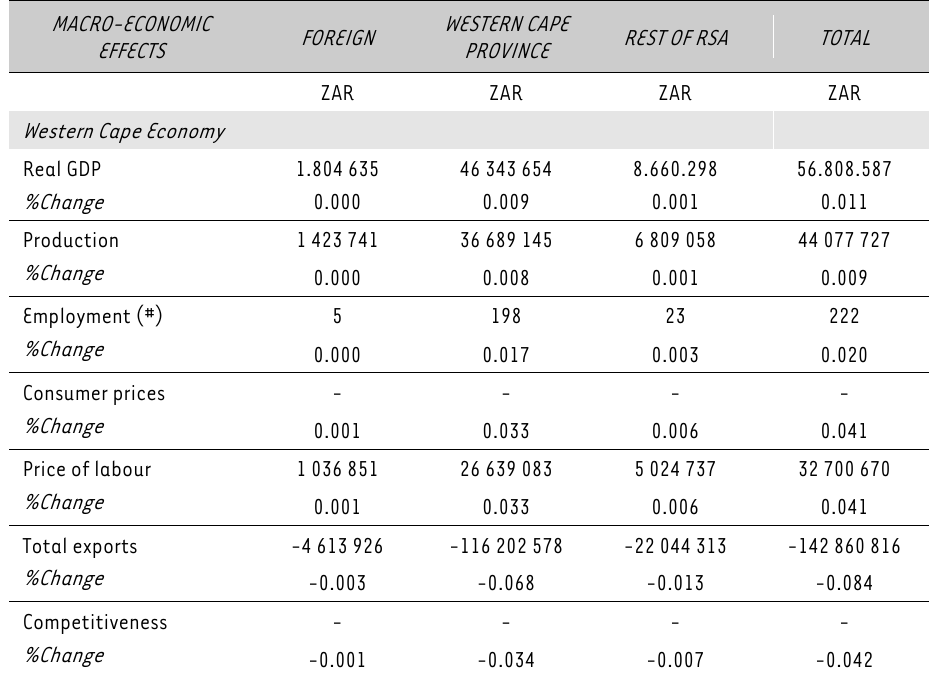
Summary of results for scenarios – provincial and sectoral level impacts